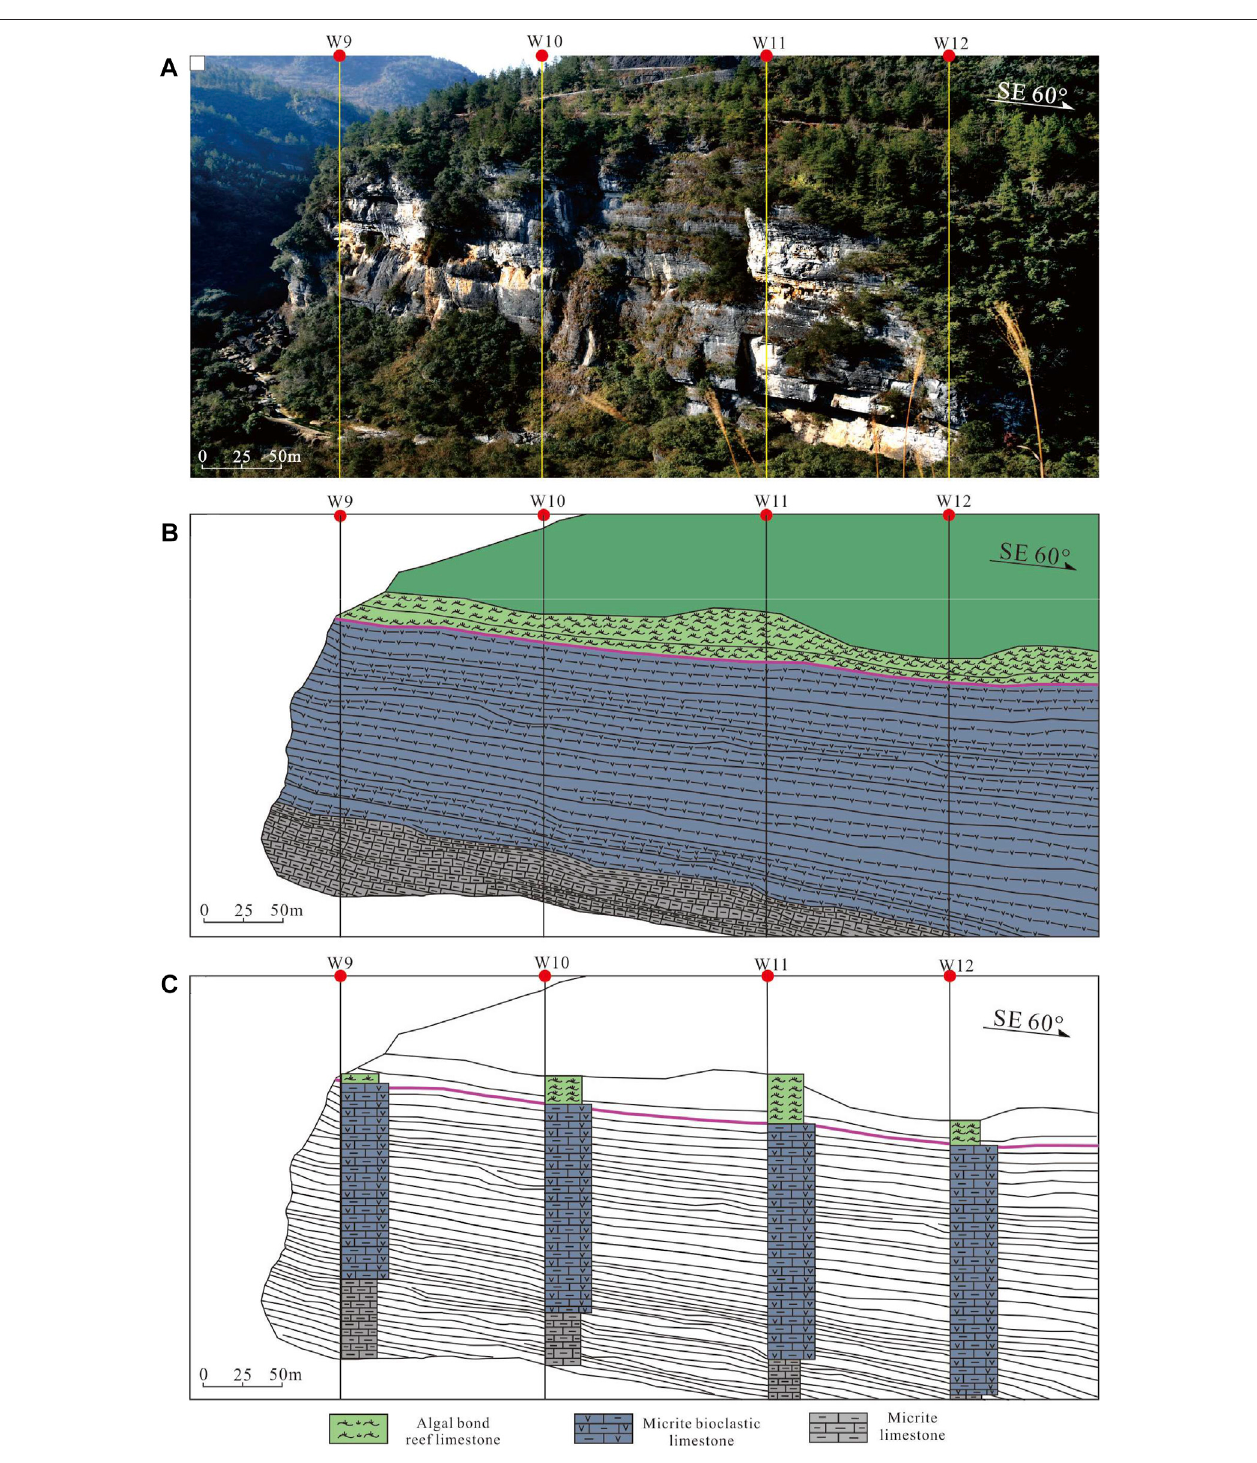
FIGURE 6 | Architecture geological model of Jiantianba BB ’ section, Lichuan. (A) Field outcrop picture; (B) outcrop pro fi le sketch; (C) architecture geological model.